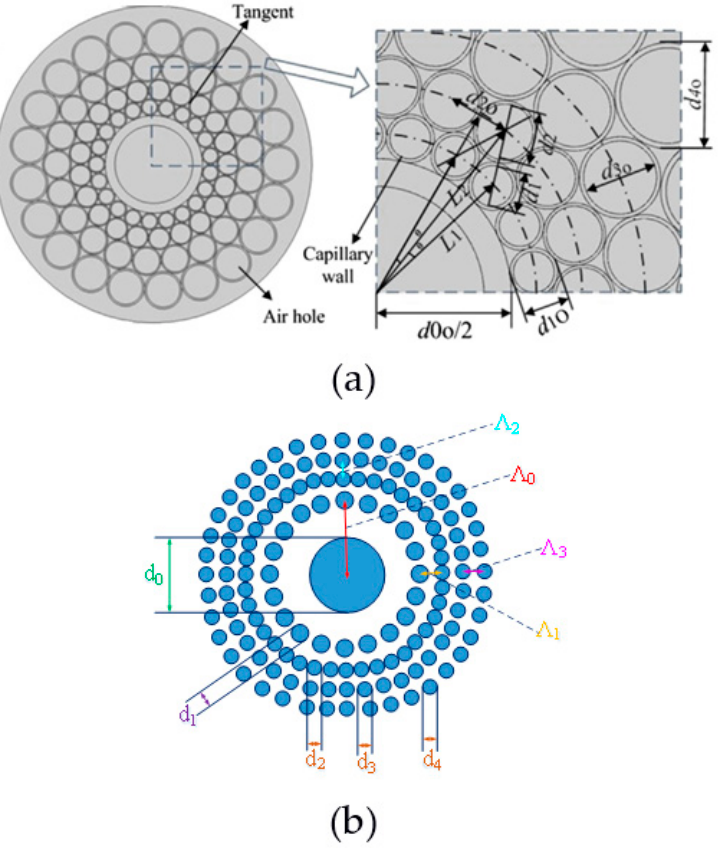
Figure 3. Cross section and structure parameters of ( a ) the microstructure ring fiber (reprinted from [37] by permission from Elsevier), and ( b ) ring PCF (reprinted with permission from [40]. Copyright 2016 Optical Society of